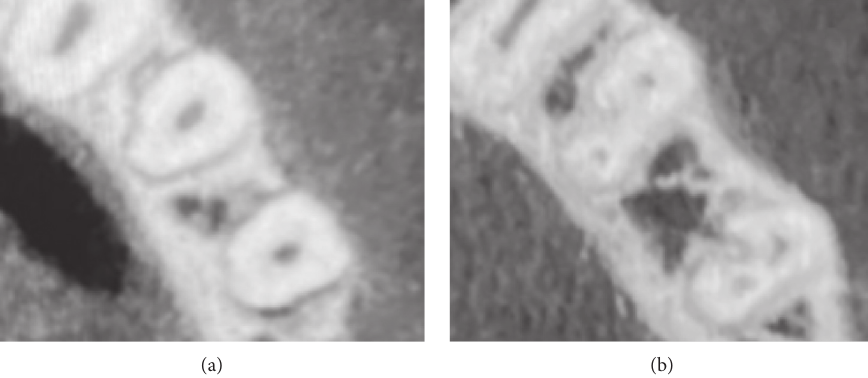
Figure 2: Different variations of root canal types in mandibular second premolar. (a) One canal; (b) two